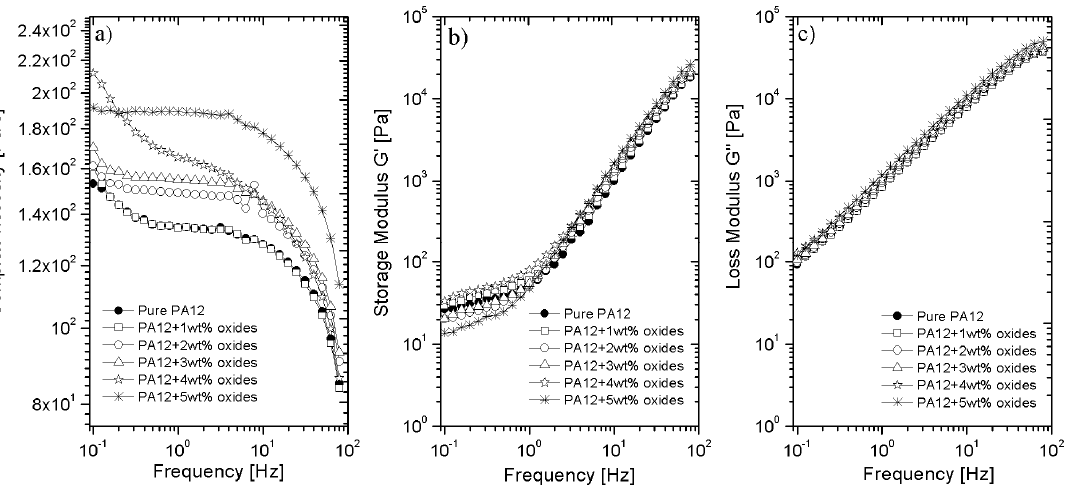
Figure 5. ( a ) Dynamic viscosity; ( b ) storage modulus G ′ and ( c ) loss modulus G ″ as a function of frequency for pure PA12 and PA12 with the addition of 1–5 wt % metals oxides.